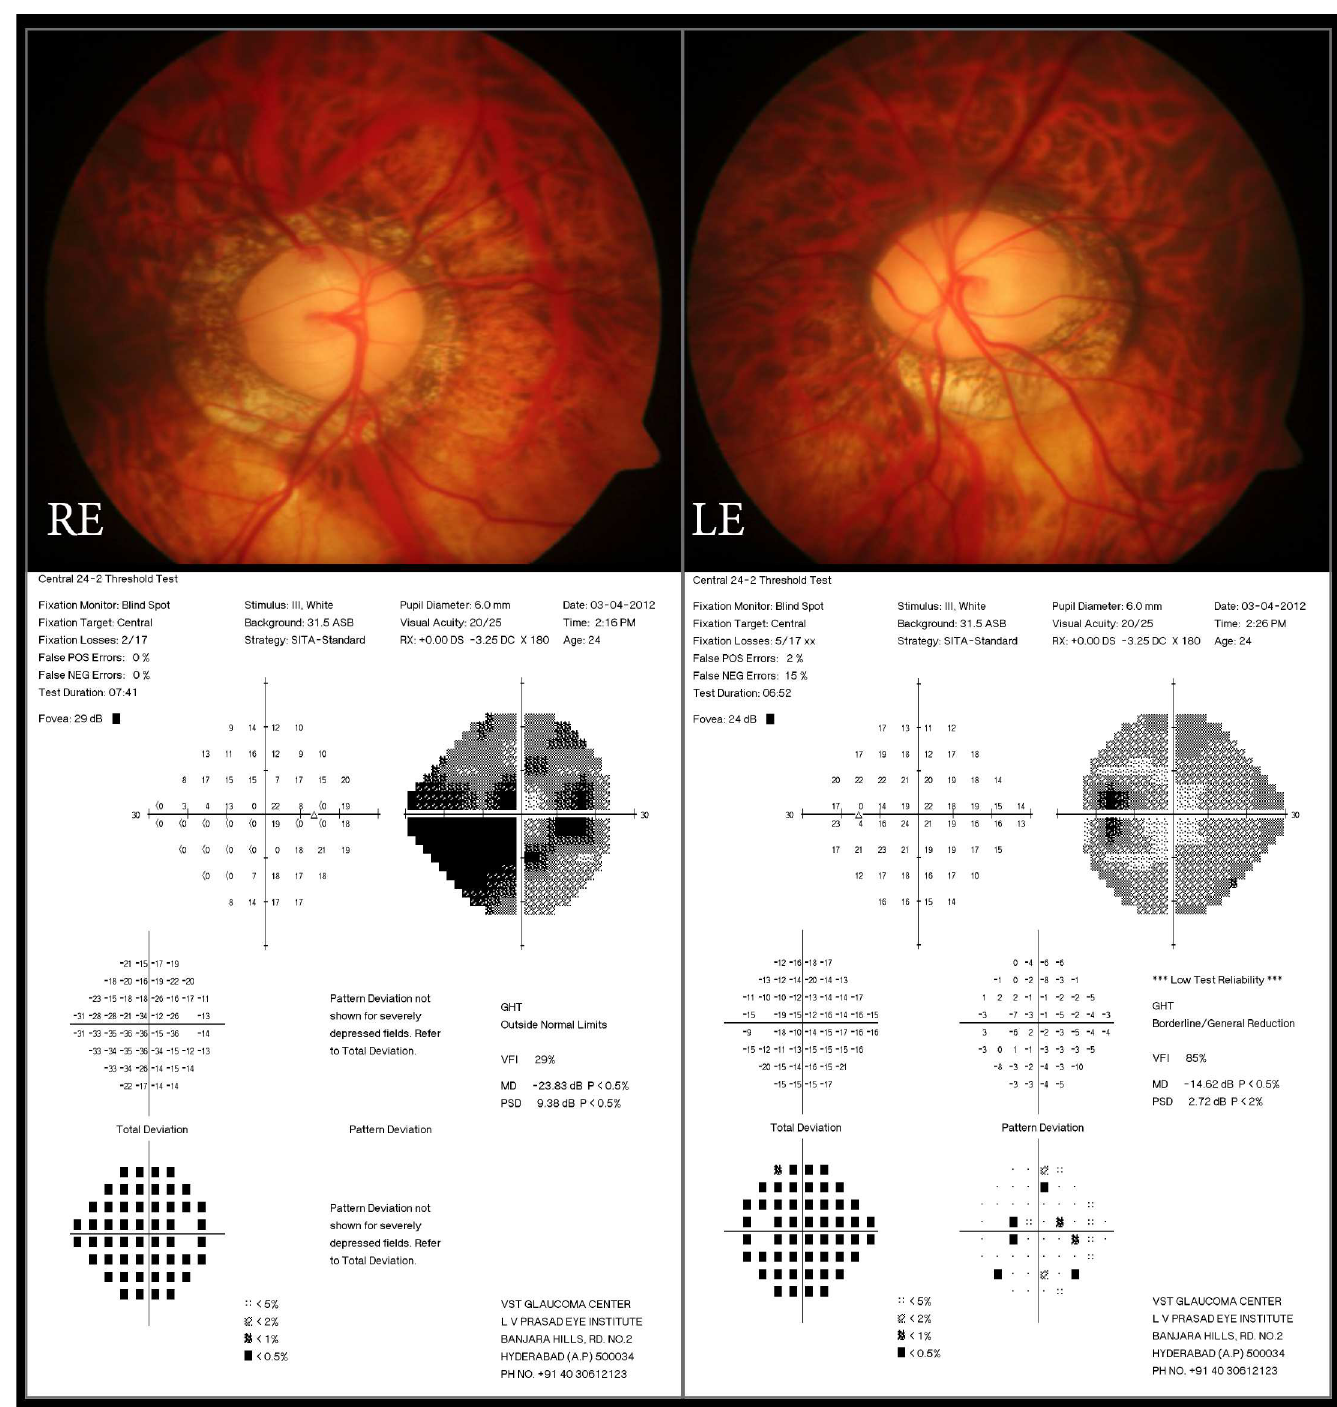
Fig 3. Optic disc photographs of the right eye (RE) and the left eye (LE) of the subject with JOAG and high myopia. Note the large discs with large cuppingand neuroretinal rim thinning in both the eyes and the corresponding visual field